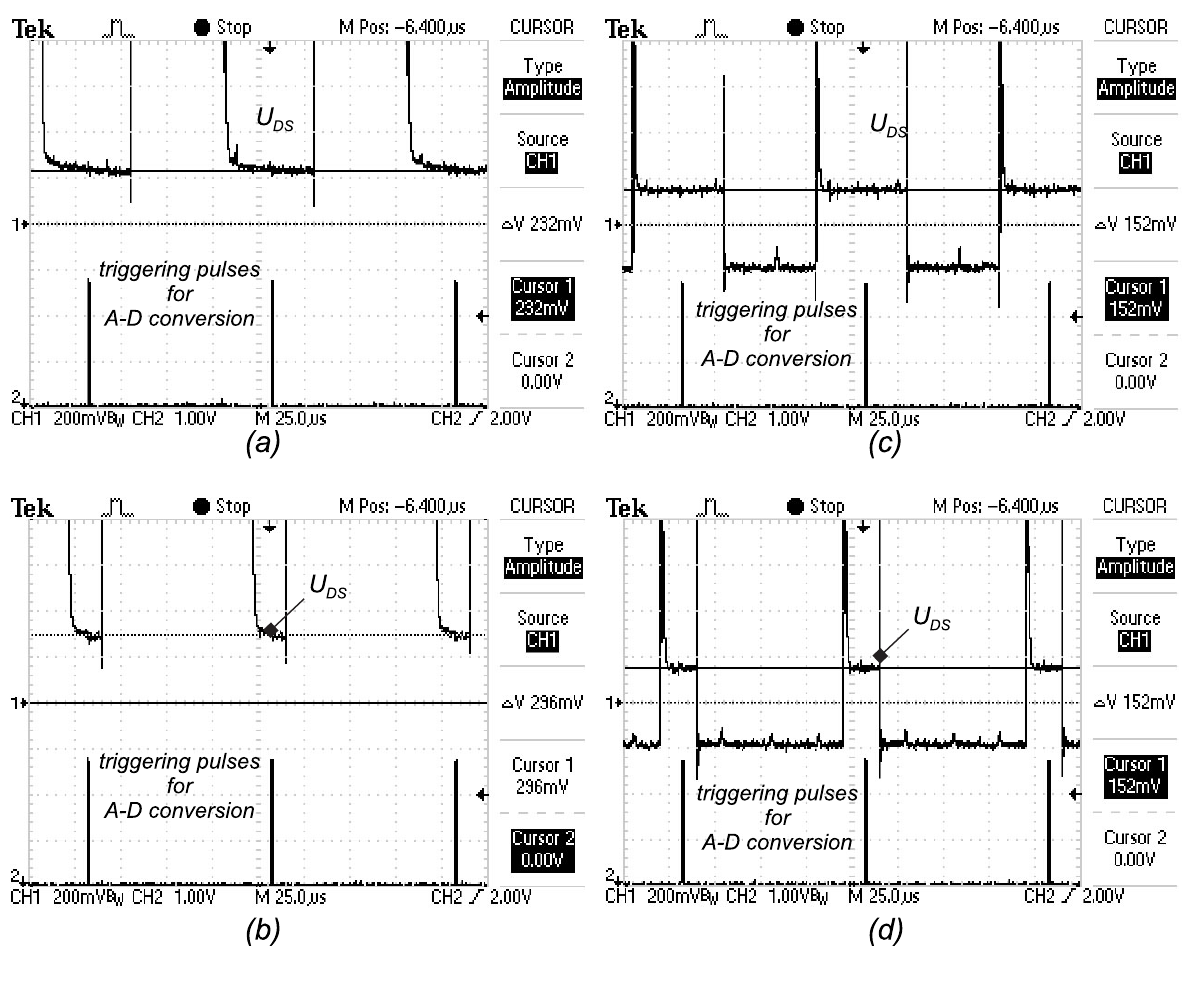
Figure 12. Measurement of U